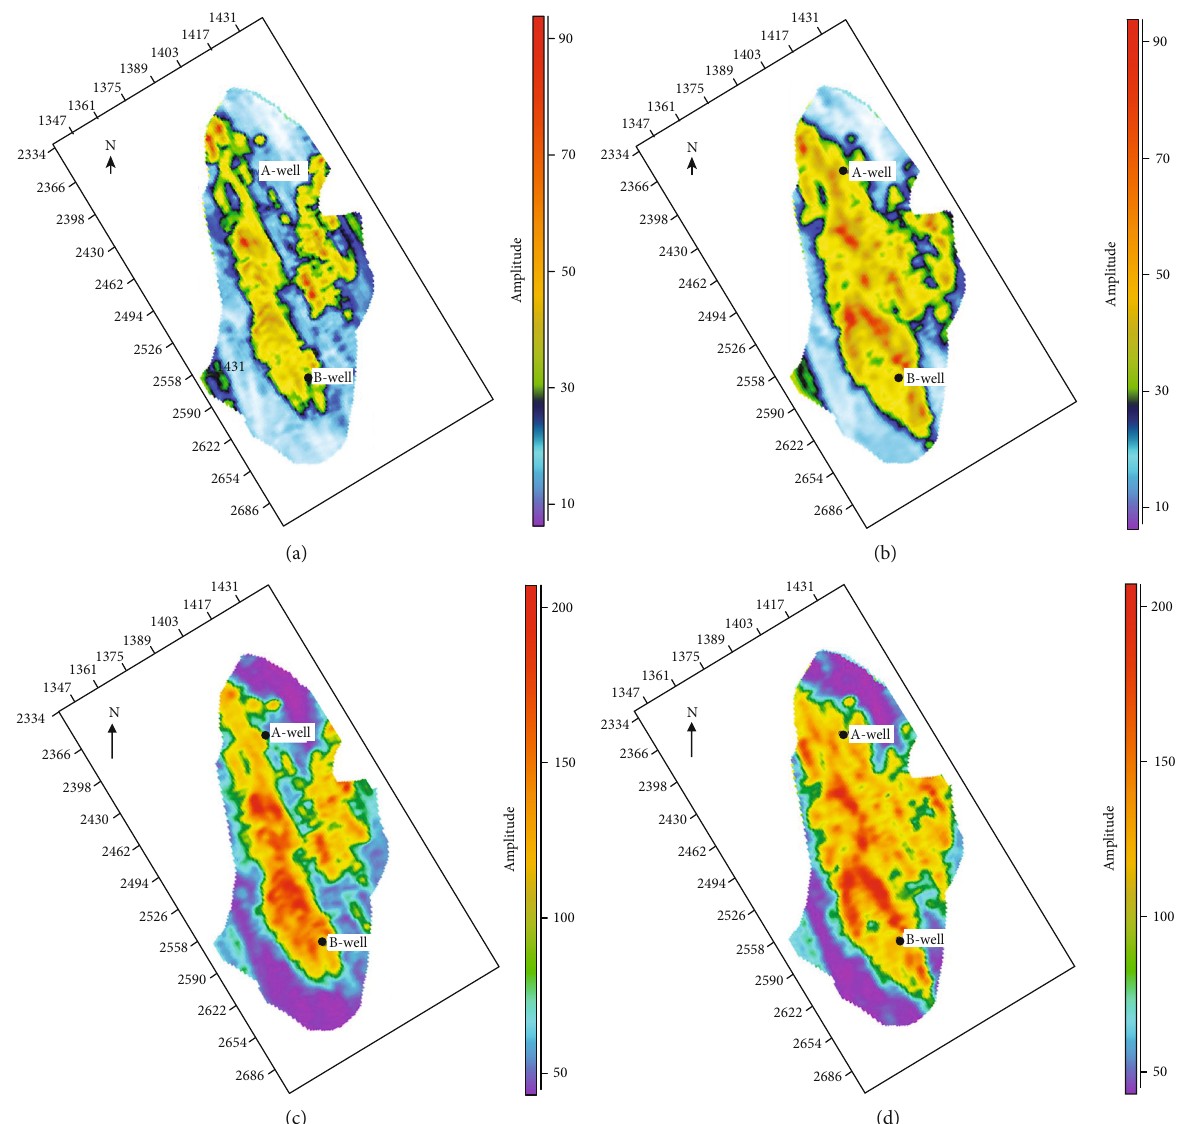
Figure 8: Root-mean-square attribute distribution of AVO intercept and gradient in the A-B ore body: (a) root-mean-square attribute of AVO intercept for gas hydrate; (b) root-mean-square attribute of AVO intercept for free gas; (c) root-mean-square attribute of AVO gradient for gas hydrate; (d) root-mean-square attribute of AVO gradient for free